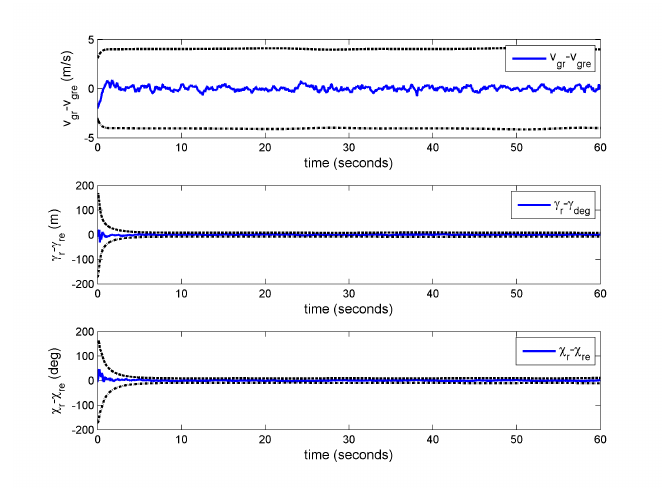
Figure 18. Speed, flight path angle, and heading angle error with 3 − σ bounds (Case